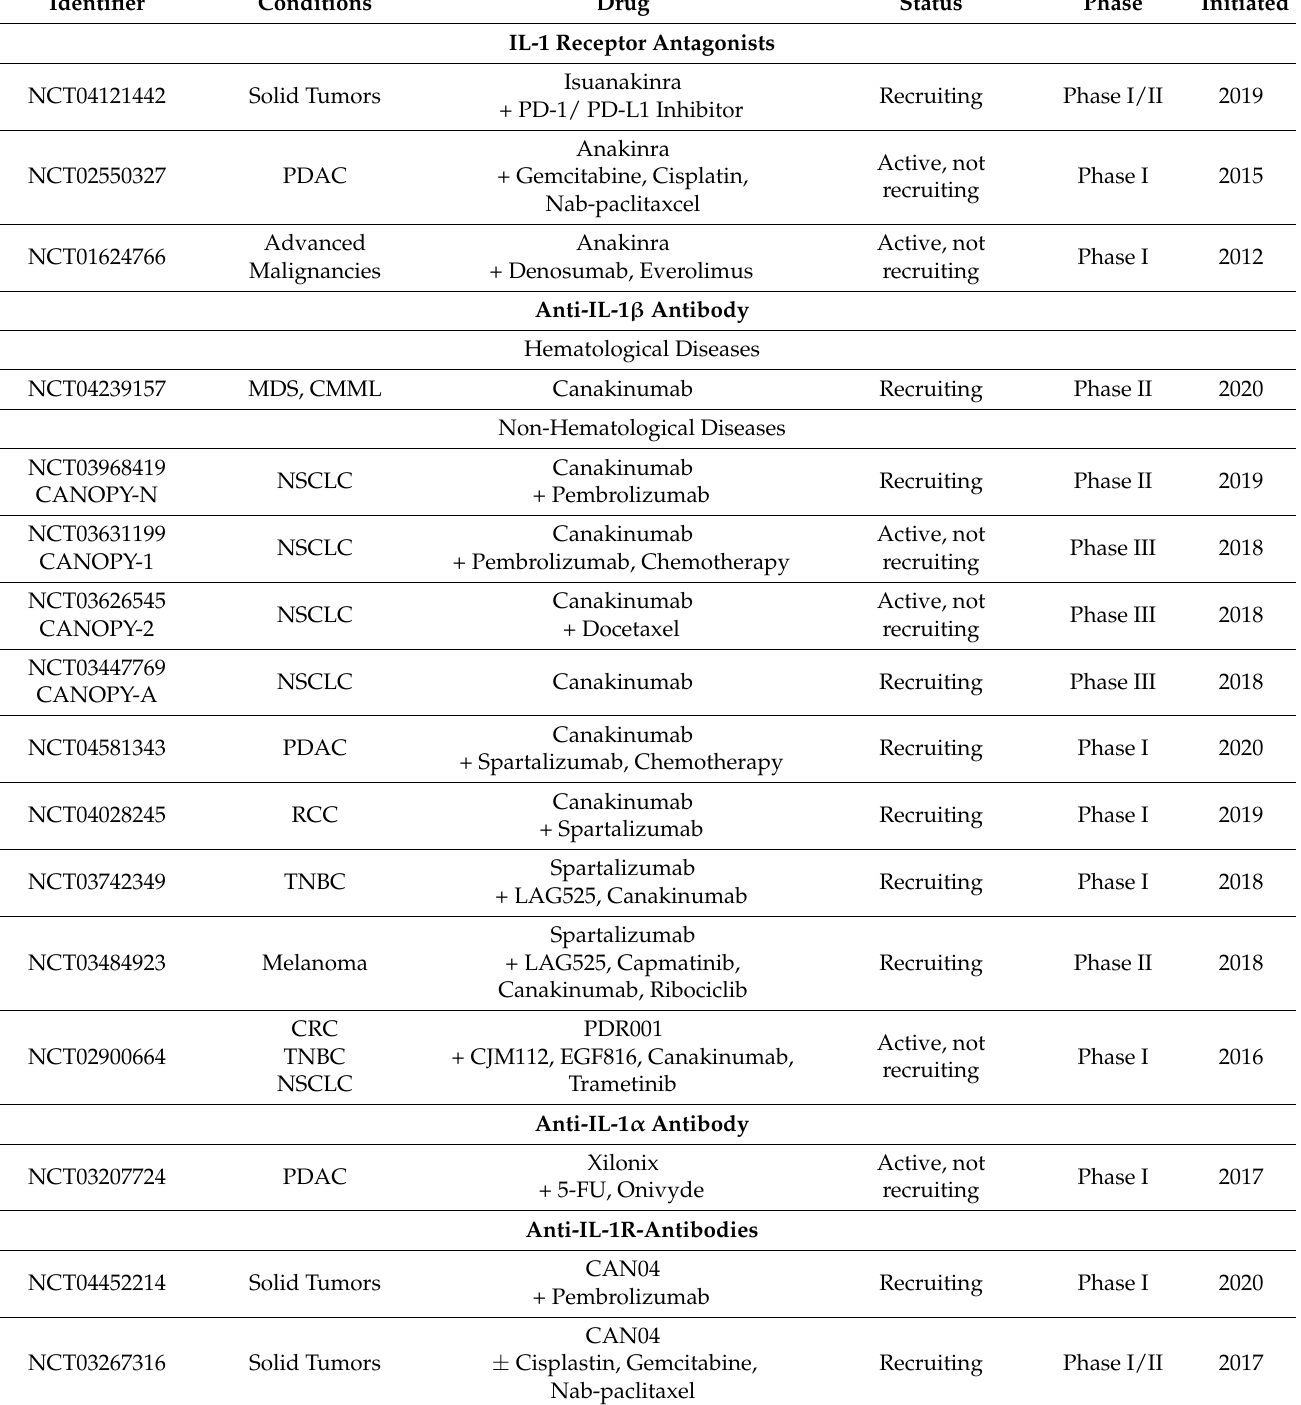
Table 1. Overview of clinical trials involving IL-1 blockade in